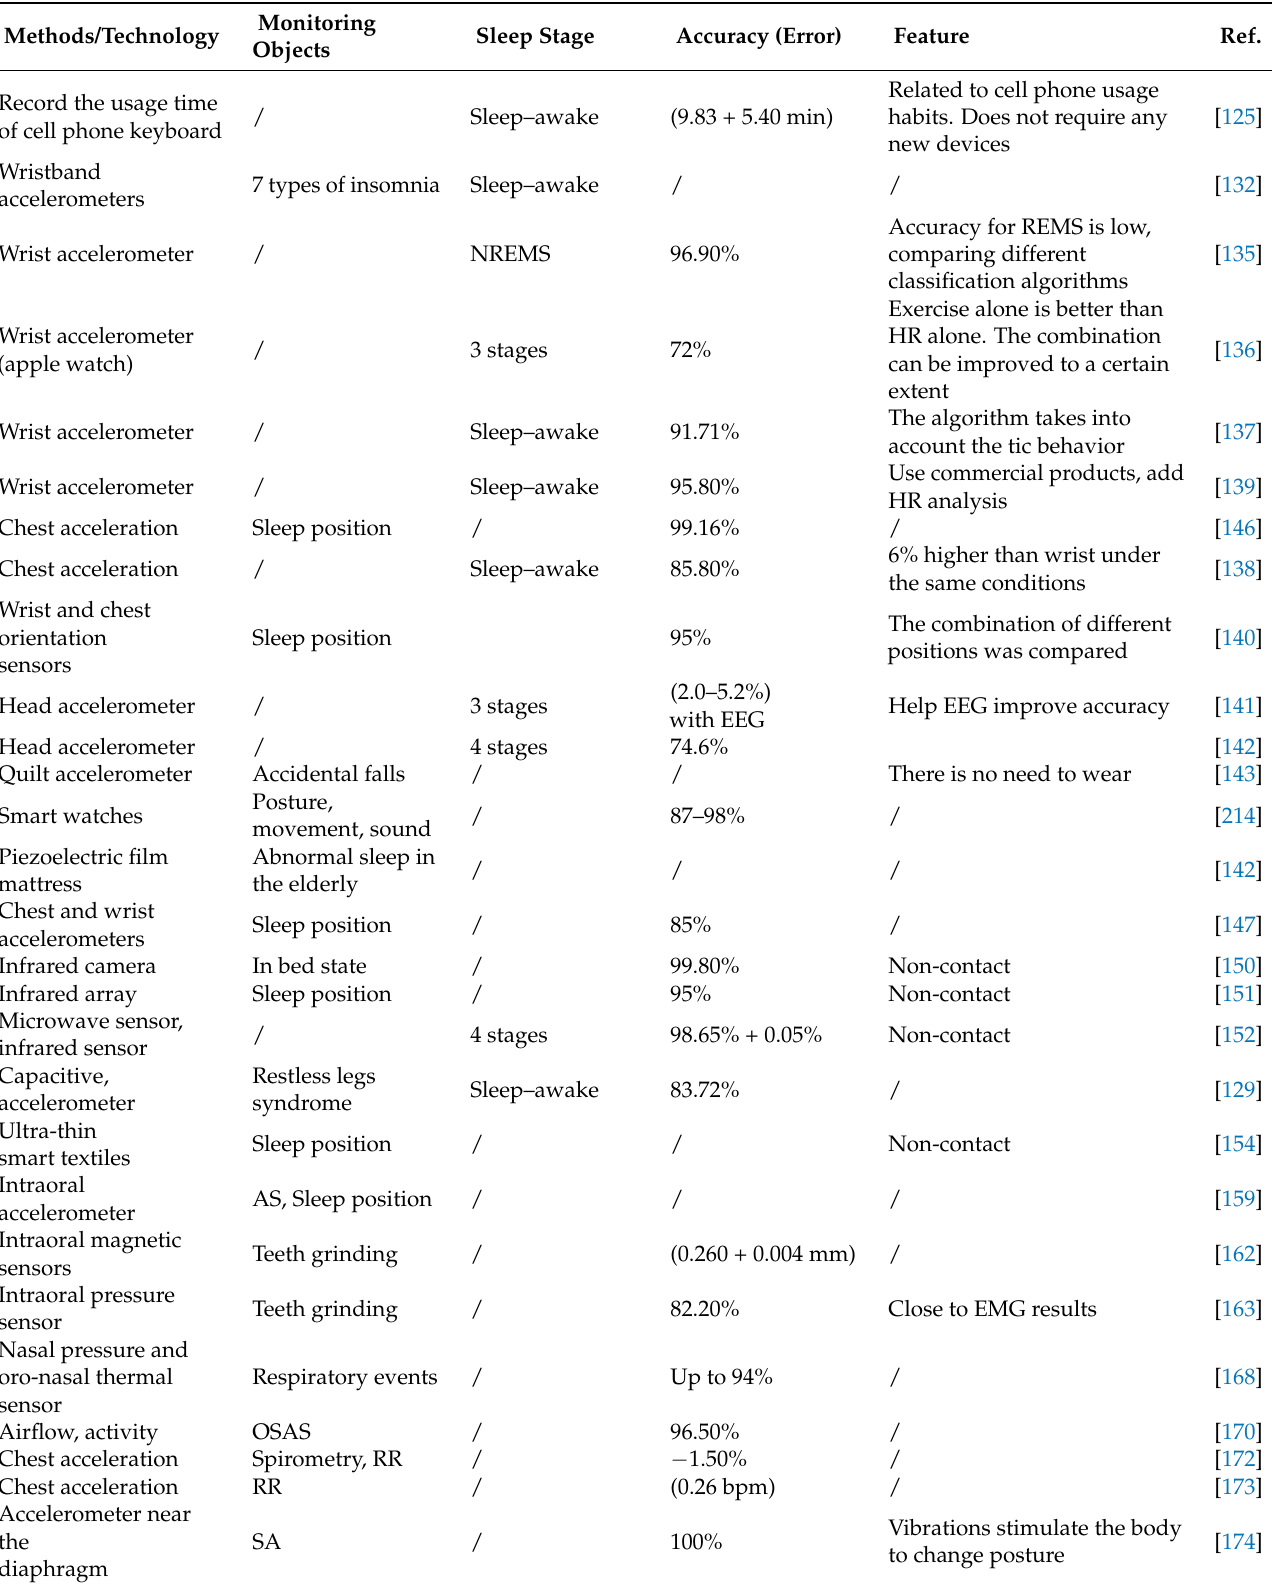
Table 2. Table of biomechanical signal